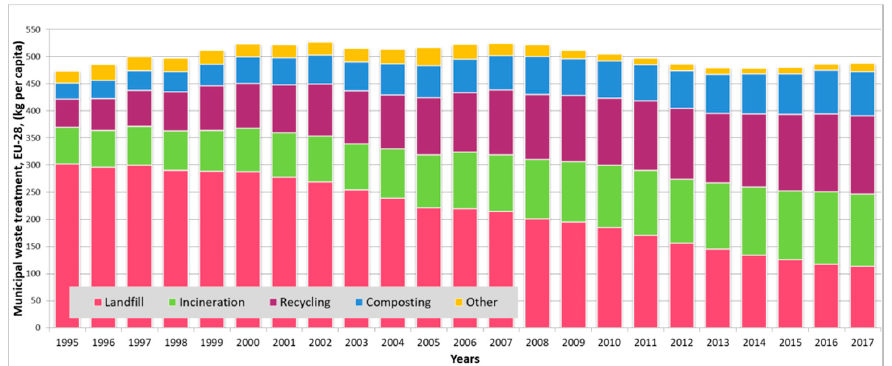
Figure 1. Trends of municipal waste treatment in European Union-28 (EU-28). The data source from [7].